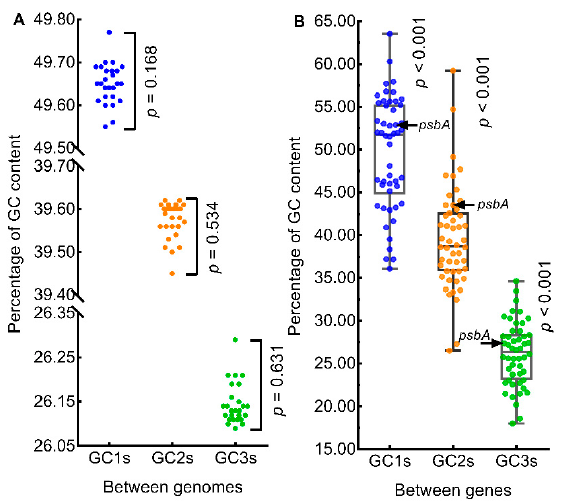
Figure 2. Comparison of nucleotide contents. ( A ) GC content of genomes. ( B ) GC content of genes. The color circles in panels ( A ) and ( B ) represent the mean GC contents of the genomes ( n = 26) and the mean GC contents of genes ( n = 50), respectively.